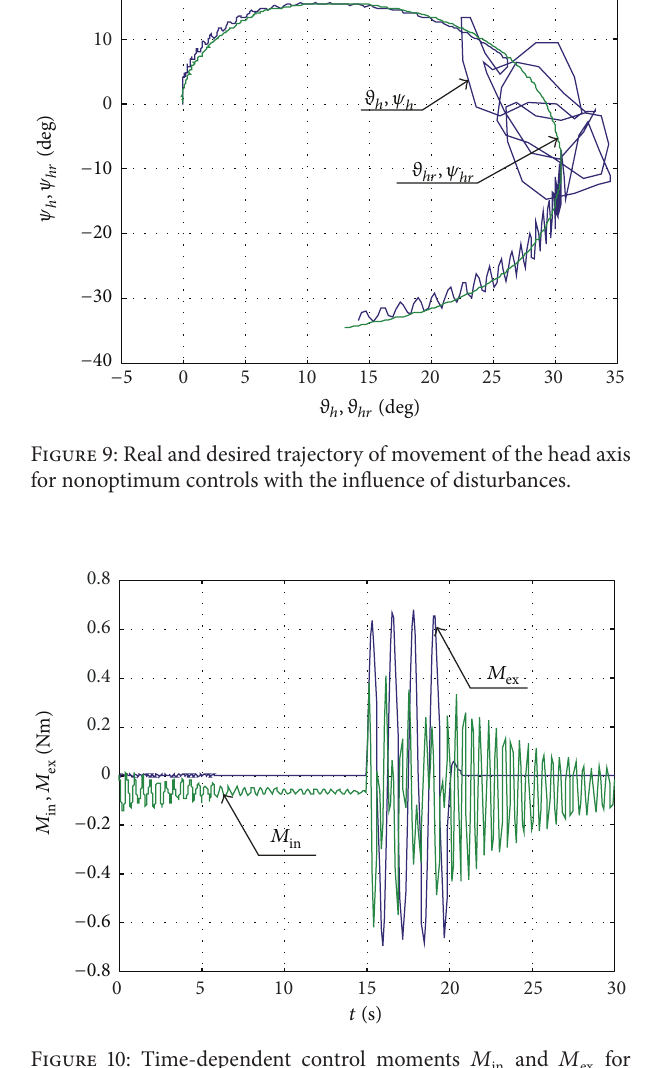
Figure 10: Time-dependent control moments 𝑀 nonoptimum parameters of the regulator with the influence of